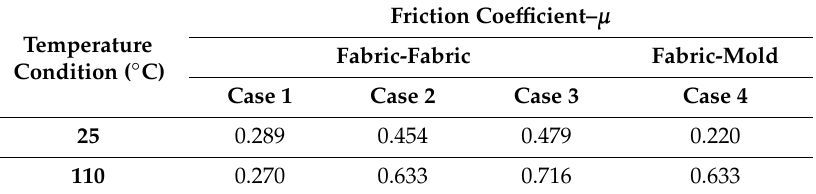
Table 4. Friction coe ffi cient of the carbon fabric as a function of temperature.